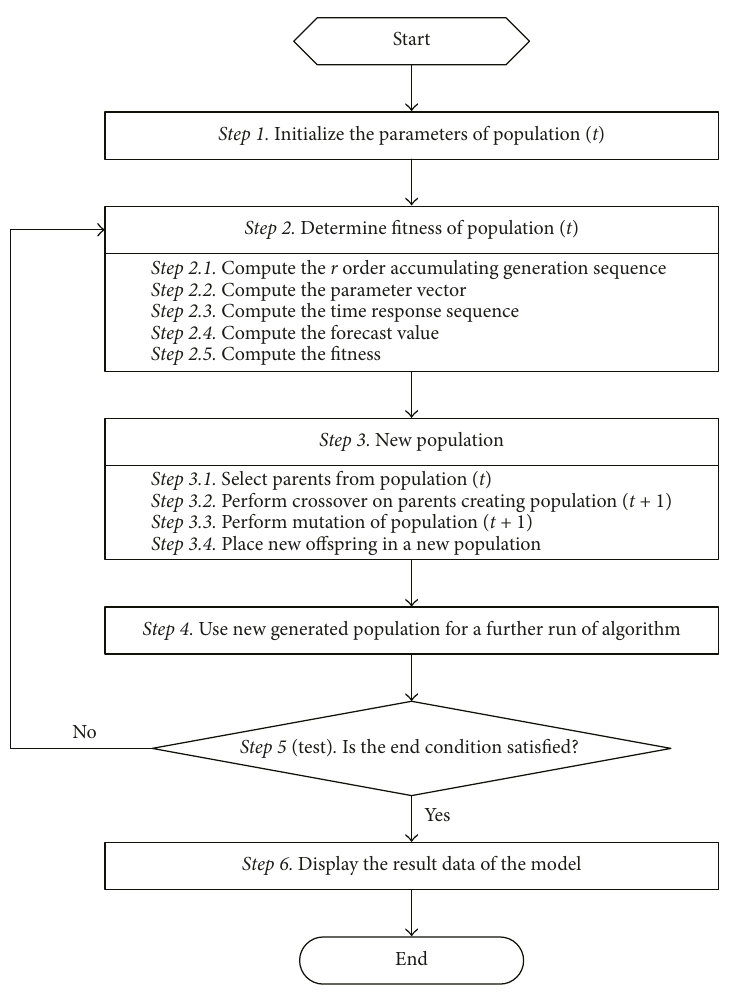
Figure 1: The modeling steps of discrete grey model with optimized fractional